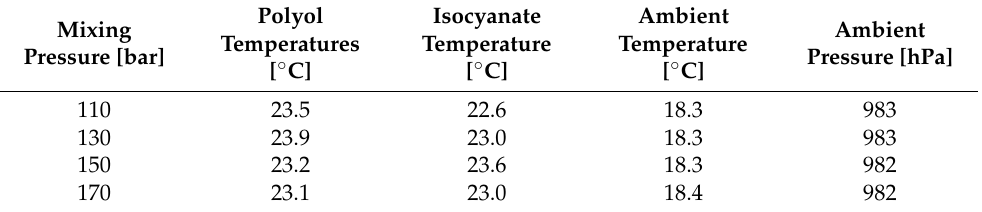
Table 1. Synthesis parameters such as component temperatures, ambient temperature and pressure.